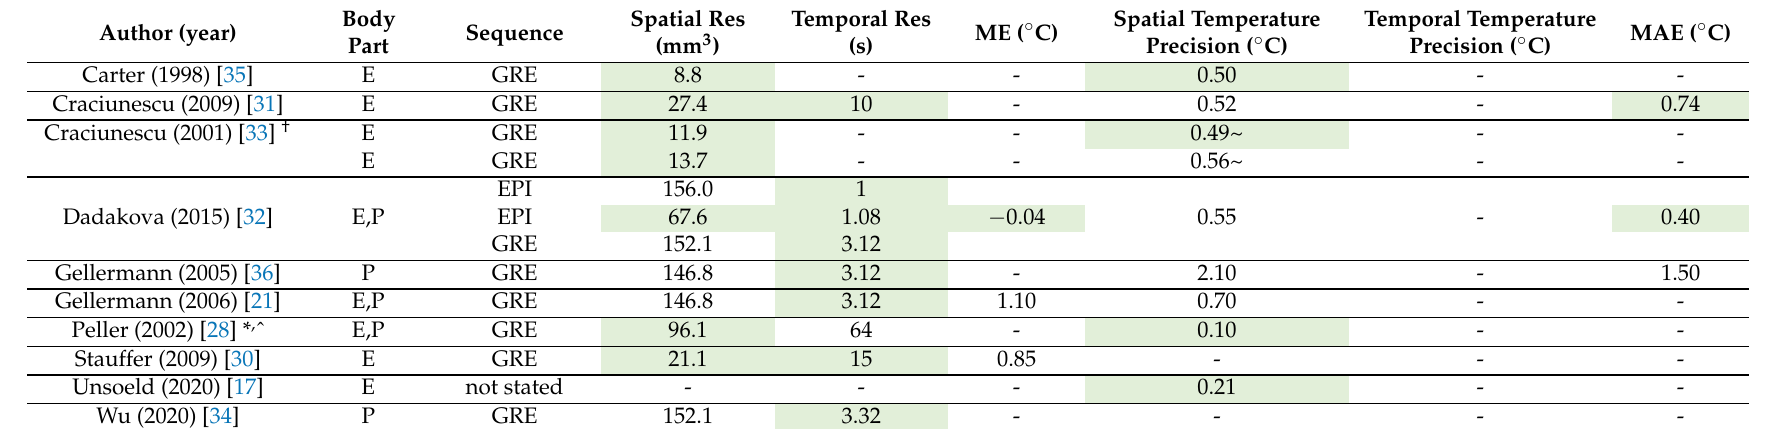
Table 3. Imaging setup for clinical